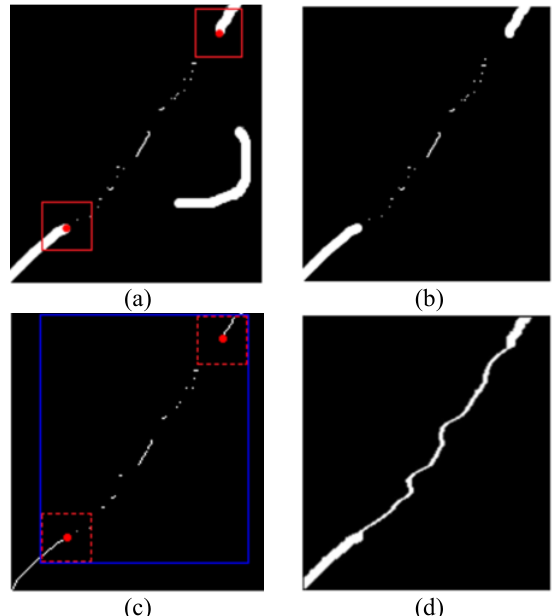
Figure 7. Demonstration of different steps of the proposed spline-based gap filling method. (a) Considered block of the founded gap. (b) Eliminating the objects outside of the desired road angle. (c) Converting into a function. (d) Interpolated road after thicken and updating by original road.